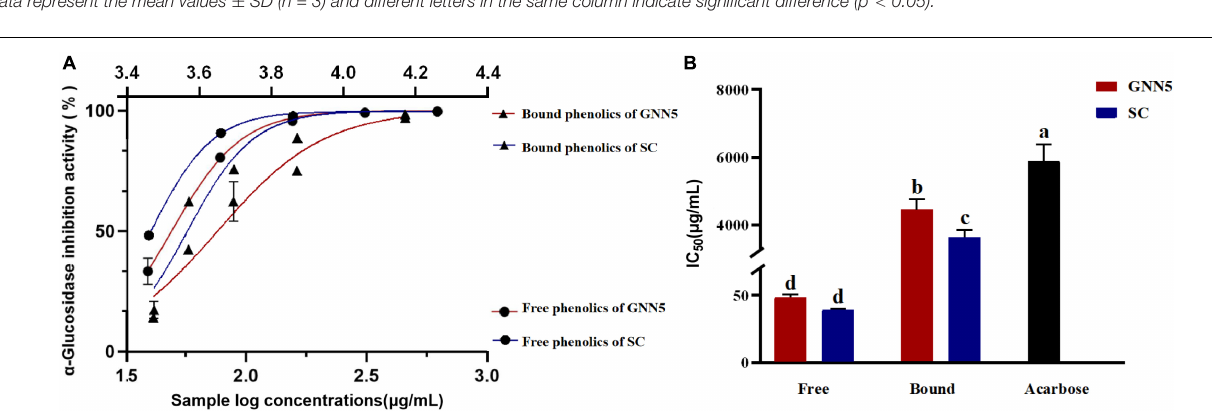
FIGURE 2 | The α -glucosidase inhibitory potency of free and bound phenolic compounds extracted from two R. roxburghii leaves (A) . Panel (B) represents the corresponding IC 50 values of the samples. Different letters denote statistically significant differences at p <